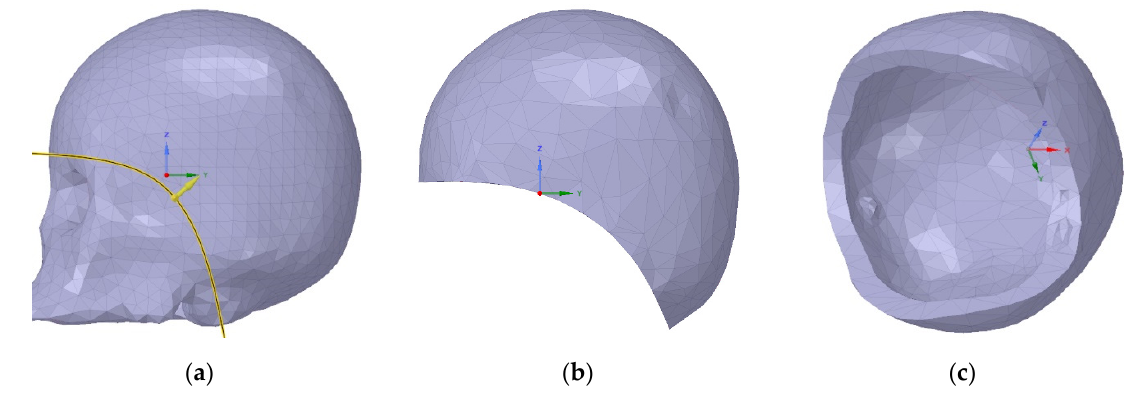
Figure 12. ( a ) Surface separation curve. ( b ) Removal of the facial region. ( c ) Internal region of skull surface. Then thermal analysis is performed using ANSYS Workbench. The temperature value of the skull’s inner surface is assumed to be 0 °C. Thus, the temperature value of any point on the skull’s outer surface gives the temperature difference directly. The heat transfer is performed within one second. There is no difference between simulating for one second or for longer with respect to the heat transfer image. In this study, the play duration for the animation was selected as one second. Simulation time does not directly inform surgical practices. In Figure 13, the left side and top views of the skull are shown. These thermal analysis results were taken in different periods of heat transfer. The color distributions in the thermal images correspond to different bone thicknesses. The red color indicates the region with the greatest bone thickness. The green color indicates the region with the thinnest bone thickness. Other colors show intermediate values of bone thickness in red and green regions. Thanks to the developed method, the bone thickness information of any desired point on the skull can be obtained numerically.